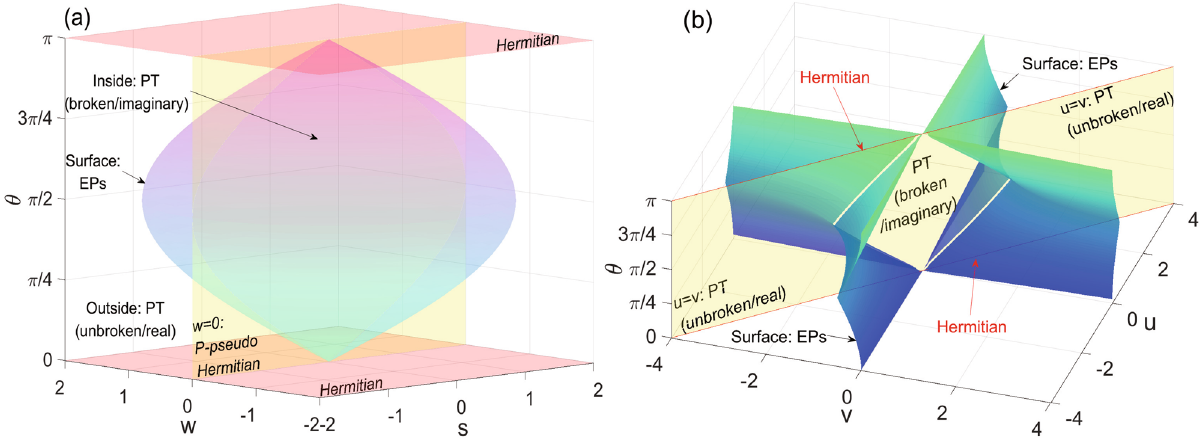
Figure 1. Parameter spaces of PT-symmetric and P-pseudo-Hermitian systems. From Eqs. (9) and (14), both the PT and PPH systems contain four parameters. Here we use the parameter space to illustrate the phase diagram of the two NH systems. ( a ) PT-symmetric systems. The parameter space is described by s , w and θ (here we set r = 2 ). There are PT(unbroken/real) and PT(broken/imaginary) phases, EPs (the curved surface satisfying (cid:31) PT = 0 ), and intersections with PPH (the yellow plane of w = 0 ) and Hermitian (pink planes of θ = 0 or π ) systems. ( b ) P-pseudo-Hermitian systems. The parameter space is described by u , v and θ (here we set r = 2 ). The saddle surface are of EPs ( (cid:31) PPH = 0 ), separating H PPH ’s with real or imaginary eigenvalues which we denote as PPH(imaginary) and PPH(real) phases in the main text. The yellow plane of u = v is the intersection of PPH and PT-symmetric